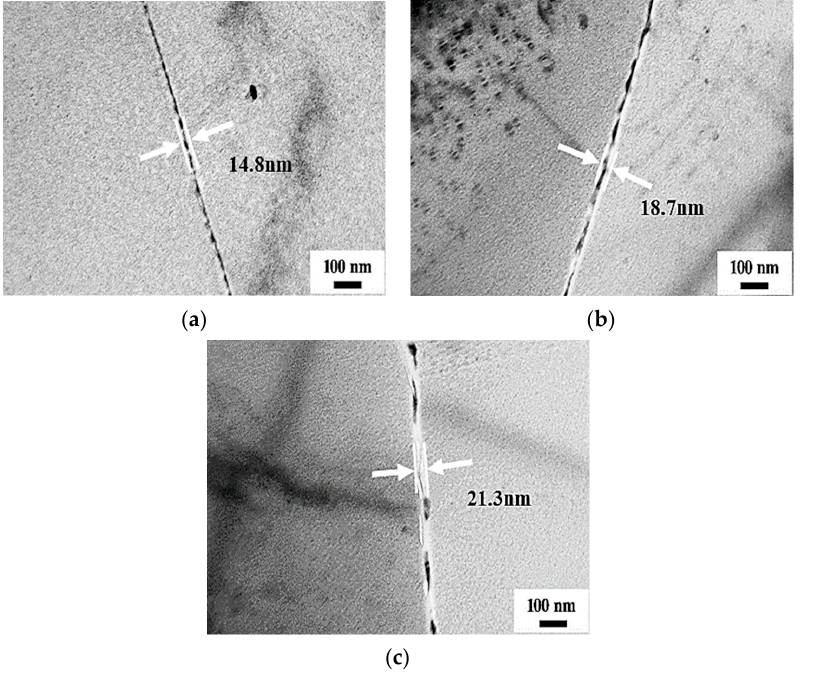
Figure 5. Grain boundary morphology of T6 alloy: ( a ) solution + aging 18 h; ( b ) solution + aging 24 h; ( c ) solution + aging 36 h.